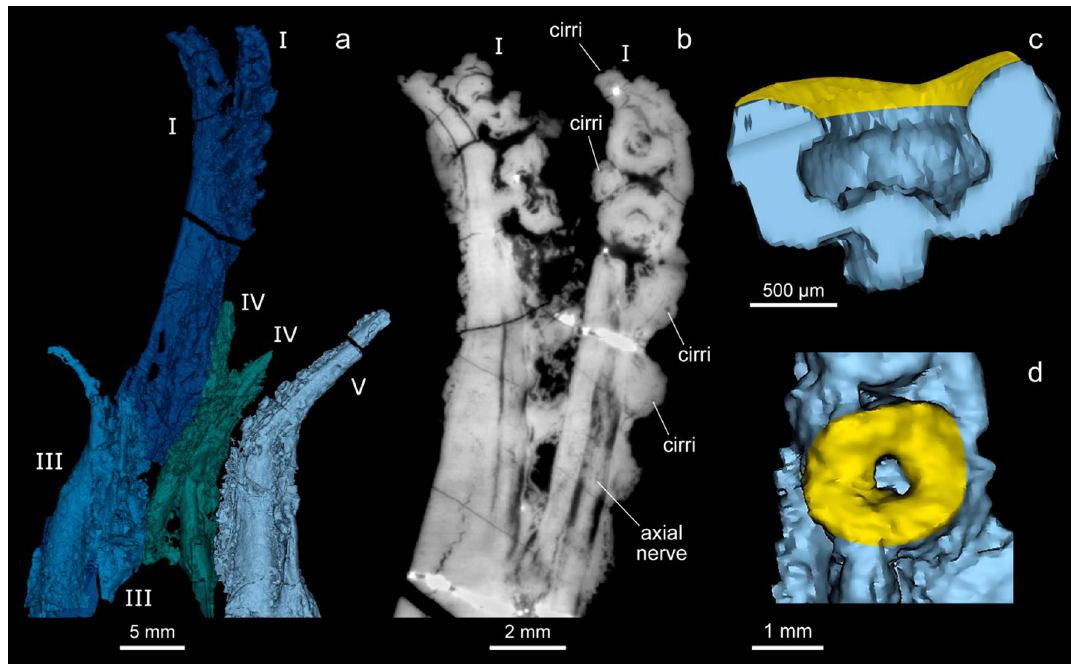
Figure 2. 3D reconstruction and image of the arm crown, and a sample dorsal sucker of V. rhodanica (MNHN.B.74244). ( a ) Reconstruction of the arm crown (Mimics software) showing 8 arms, with the longer dorsal arm pair (arm pair I). ( b ) PPC-SRµCT slice of arm pair I (voxel size: 12.64 µm) showing the armature (2 uniserial suckers and flanking pairs of cirri) at the distal section, and the axial nerves. ( c,d ) 3D reconstruction of a dorsal sucker in profile and oral view respectively. The yellow colour reflects the location of the